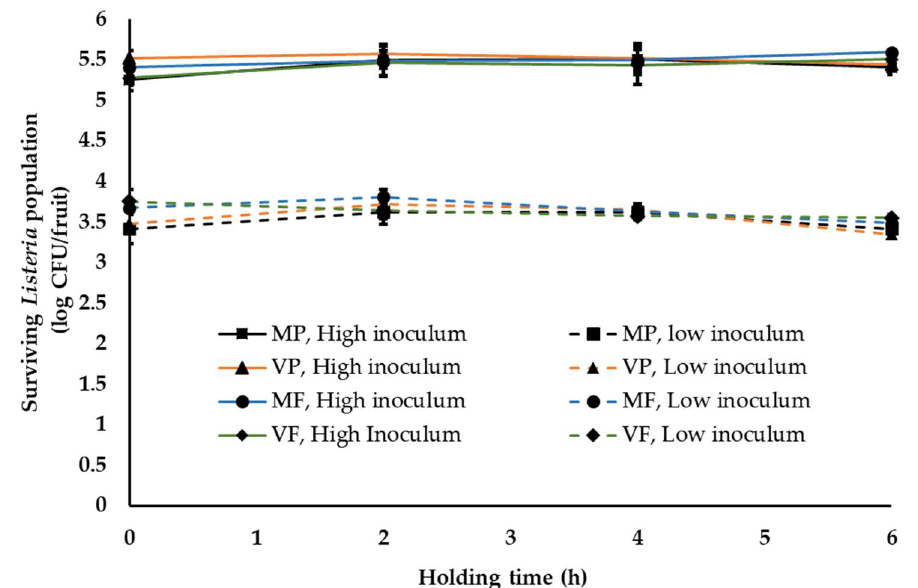
Figure 2. Listeria survival on peaches following fruit waxing and fungicide application under simulated packinghouse conditions (temperature—18–20 ◦ C (ambient cool temperature), RH—40–50% (ambient humidity) and holding time—1 to 6 h) at high (~5 log CFU/fruit) and low (~3 log CFU/fruit) pathogen load. Fruit finish formulations used in the study include MP, mineral oil + propiconazole; VP, vegetable oil +propiconazole; MF, mineral oil + fludioxonil; and VF, vegetable oil + fludioxonil. Data are represented as the mean ± SE.